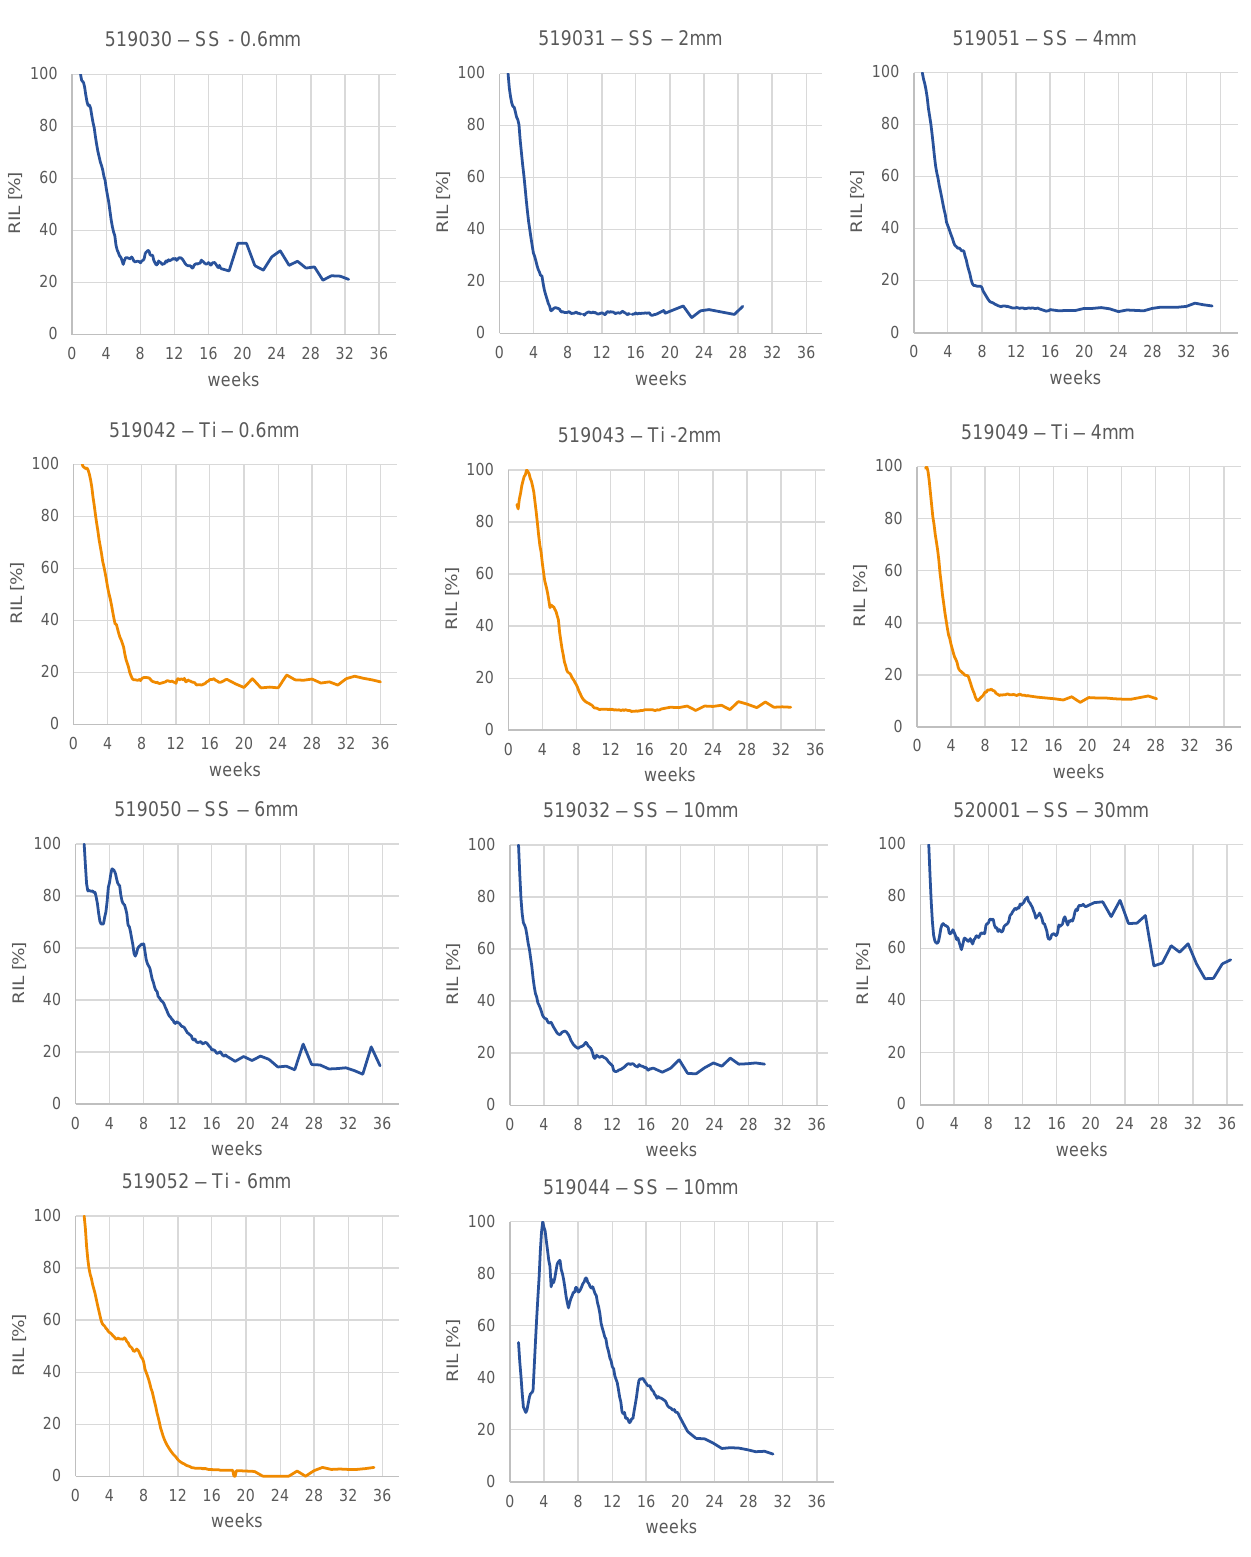
Figure 4. Relative implant load (RIL) curves for all animals in the study. Constructs with Titanium (Ti) plates in orange; stainless steel (SS) constructs in blue. Osteotomy gap sizes given in mm. Animal 519044 was reoperated 3 weeks post-operation.